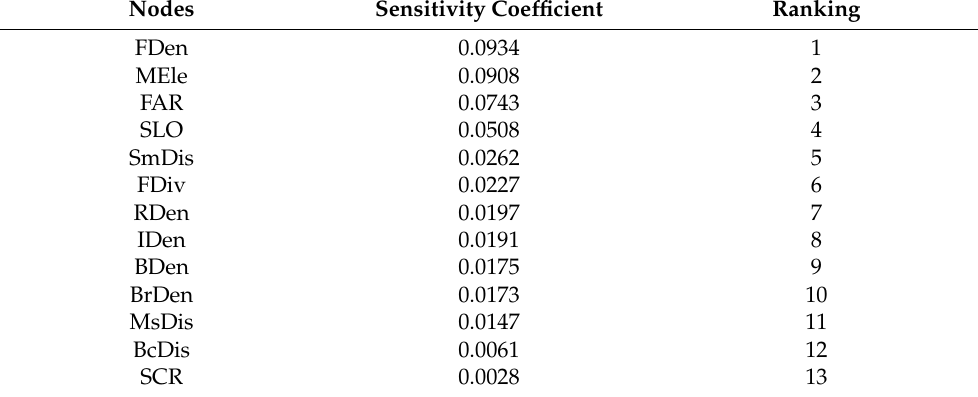
Table 7. Sensitivity